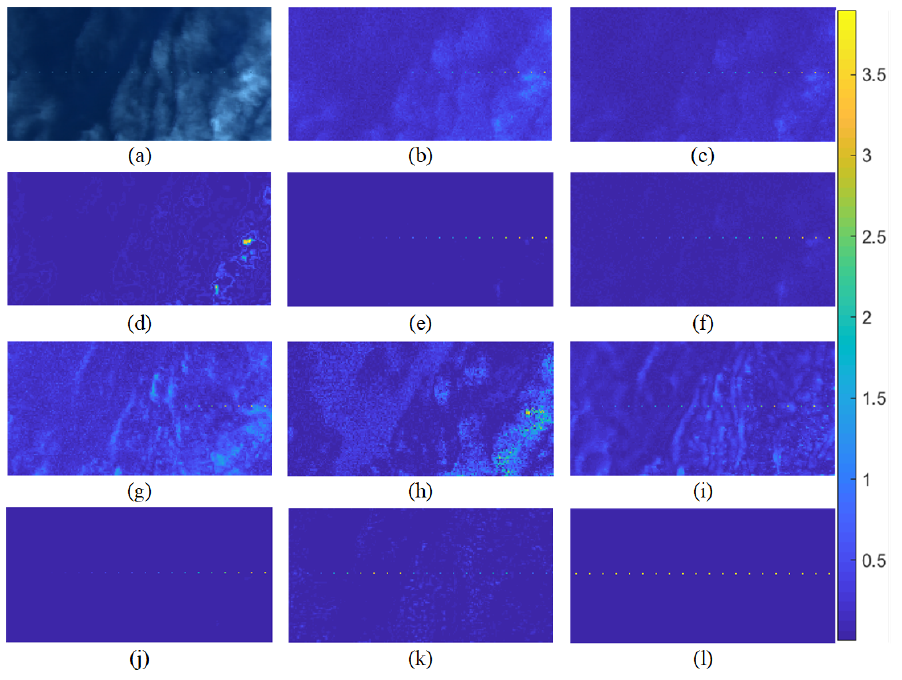
Figure 13. Detection results on the simulated dataset: ( a ) Pseudo-color image; ( b ) RX; ( c ) RX-DWT; ( d ) RX-Kernel; ( e ) RPCA; ( f ) LSMAD; ( g ) LRASR; ( h ) FrFE; ( i ) GTVLRR; ( j ) FEBPAD; ( k ) proposed method; ( l ) ground